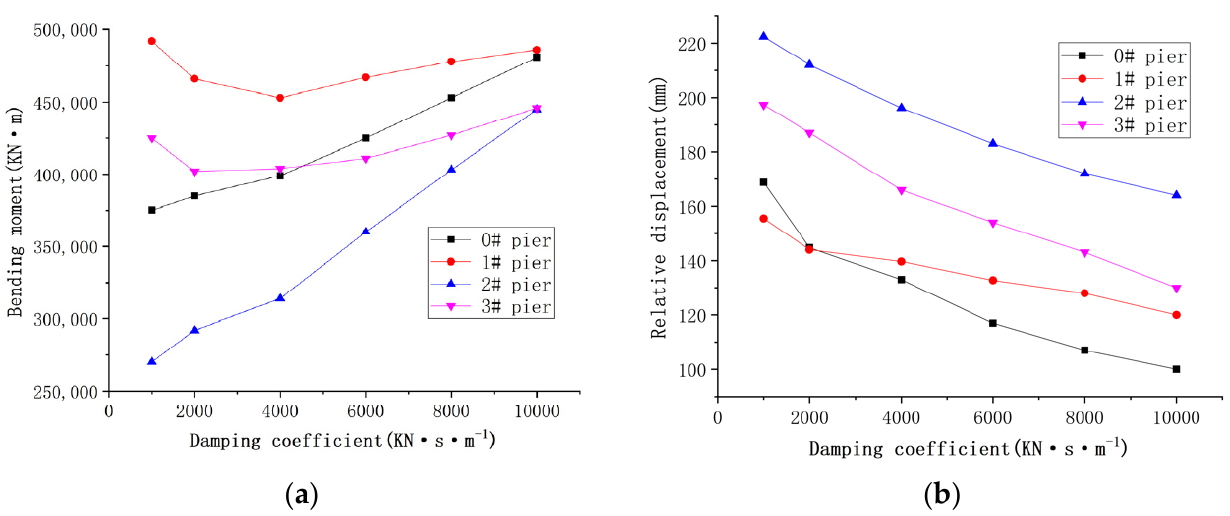
Figure 12. Seismic response of the longitudinal bridge direction (damping coefficient C). ( a ) Bending moment at the bottom of pier. ( b ) Relative displacement between piers and beams. It can be seen from Figure 12 that, in the change process of C from 1000 to 10,000, compared with the seismic structure, the relative displacement between the piers and beams can be effectively reduced; however, with an increase in C, the output of the damping force will be larger, which will limit the displacement of the upper structure, but is not conducive to dissipating the seismic inertia force; the upper inertia force is transmitted to the lower structure, which increases the bending moment at the pier bottom. It is proposed to set damping coefficient C as 6000, and the damping exponent as 0.3, 0.4, 0.6, 0.8, and 1.0. When the damping exponent is 1.0, the damper is a linear damper. The specific results are shown in Figure 13.